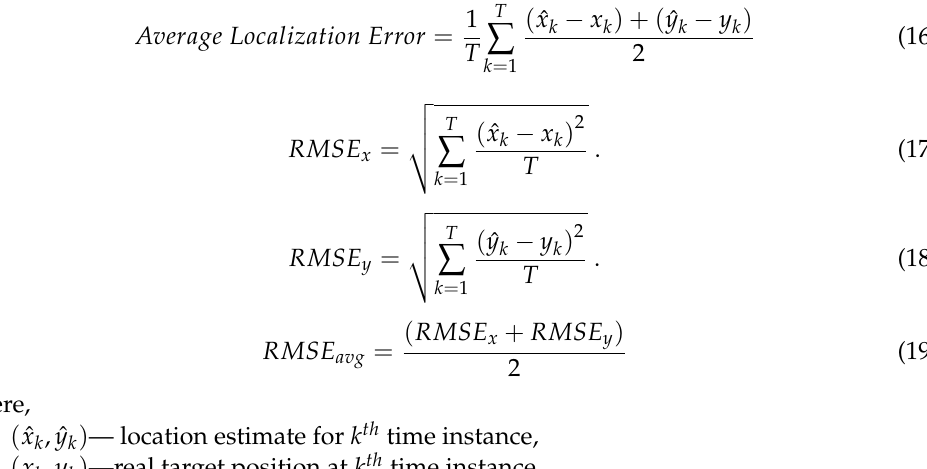
Figure 3. ( a ) Target velocity in x direction, ( b ) target velocity in y direction. The performance evaluation parameters used in this work were root mean square error (RMSE) and average localization error as given below in Equation (16) to Equation (19). All the three RMSE’s and localization error ideally must be as low as possible.